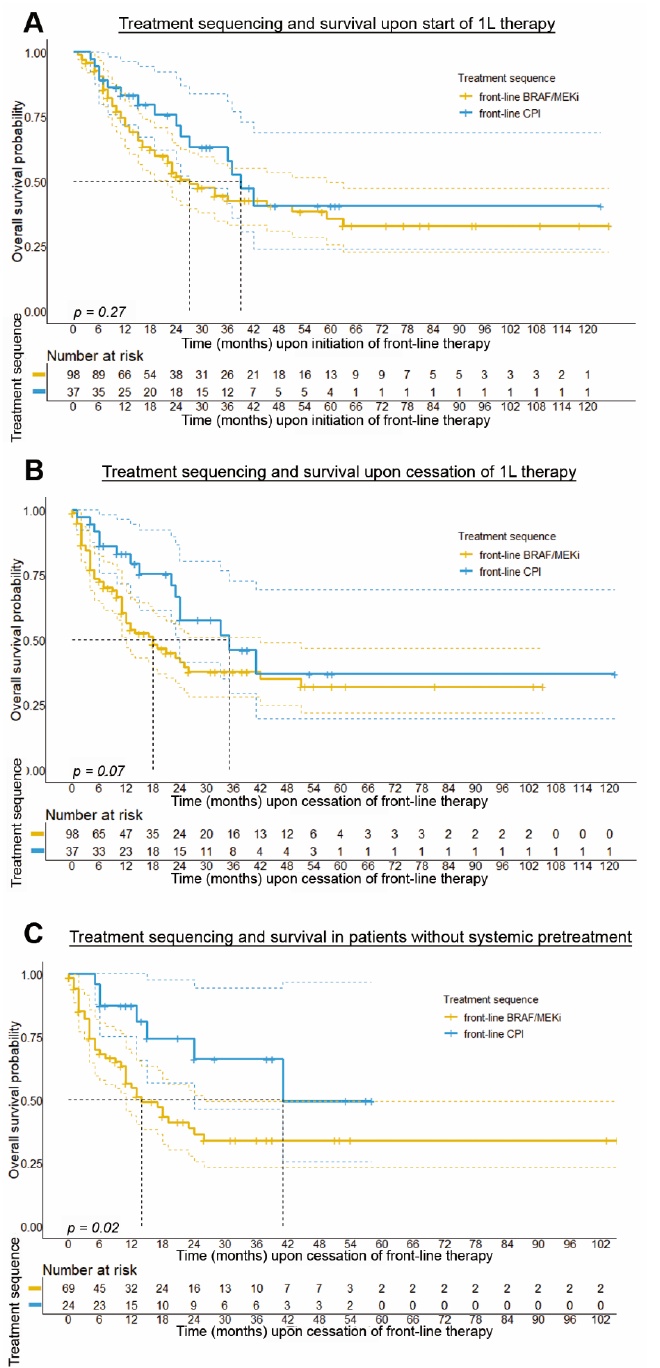
Figure 4. Overall survival of patients stratified by the treatment regimen applied. Survival curves show the results of Kaplan–Meier analysis with median OS as primary endpoint, which has been calculated both from initiation of 1L therapy ( A ) and after cessation of 1L therapy ( B , C ). Results from subsequent statistical survival analysis using log-rank test reveal that patients who received front-line CPI followed by BRAF ± MEKi therapy showed no statistically significant differences in median OS when calculated from initiation of 1L therapy (median OS: 39.0 vs 29.0 months, p = 0.269; ( A )) or upon cessation of front-line treatment (median OS: 35.0 vs 18.0 months, p = 0.070; ( B )). However, there was a trend towards a better median OS for patients given front-line CPI followed by BRAF ± MEKi therapy. In a sub-cohort of patients without systemic pretreatment ( C ) front-line CPI treatment was associated with a significant survival benefit (median OS: 41.0 vs 14.0 months, p = 0.020).